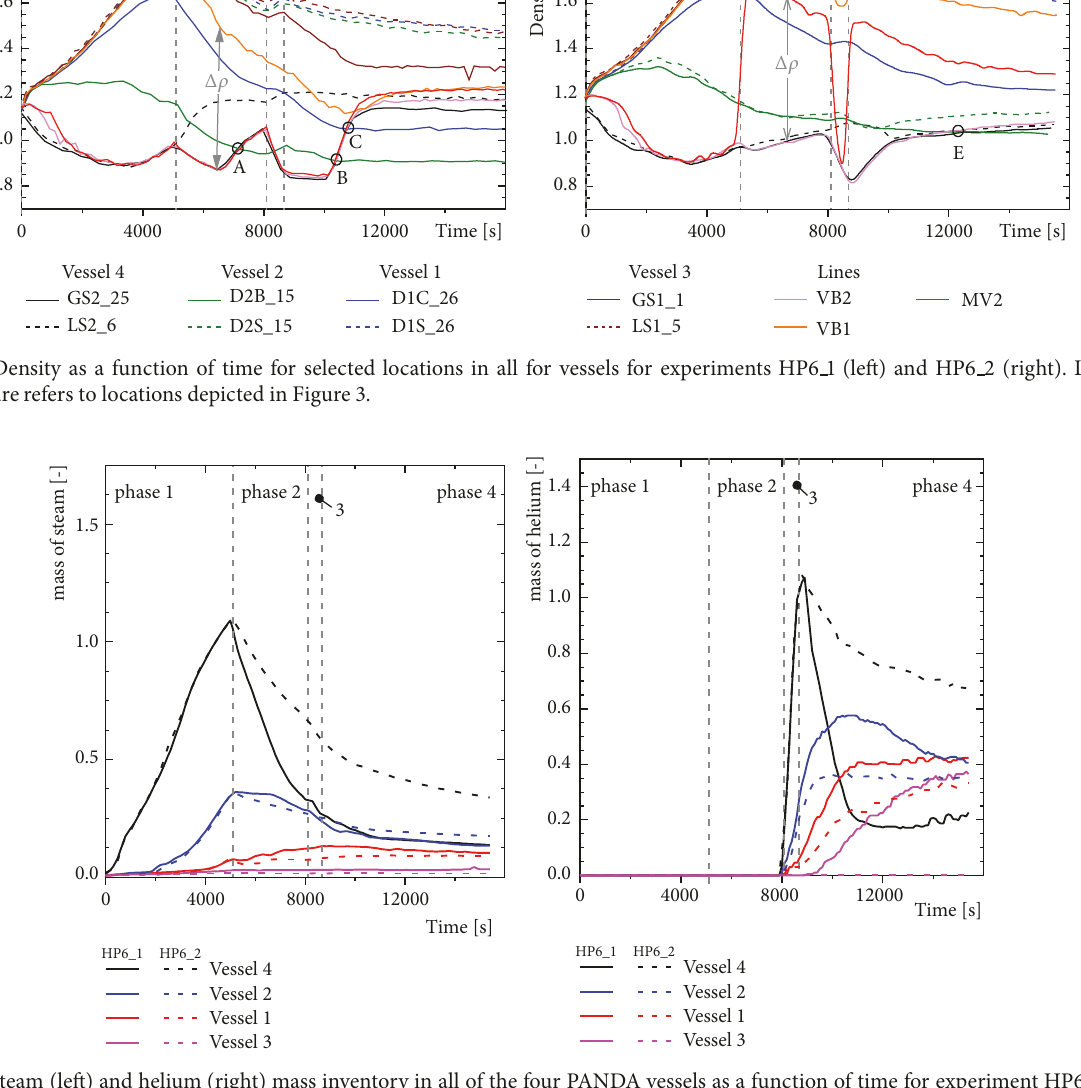
Figure 6: Steam (left) and helium (right) mass inventory in all of the four PANDA vessels as a function of time for experiment HP6 1 and HP6 2. Masses are presented in arbitrary